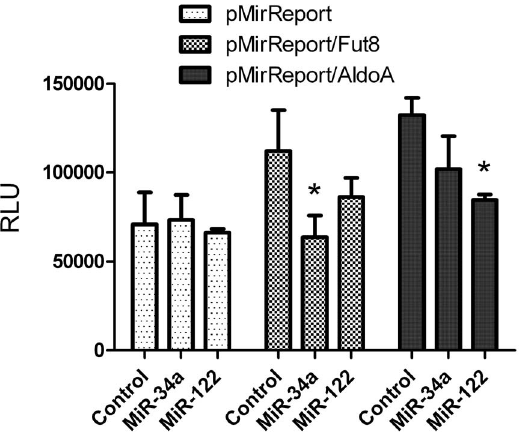
Figure 1. Effects of miR-122 and miR-34a on FUT8 and ALDOA 3 9 UTRs in a luciferase reporter assay. For each experiment, HeLa cells were seeded in 96 plates (six replicates for each condition) and they were then co-transfected with either miR-122 or miR-34a mimics and with empty pMiR-Report, with pMiR-Report containing down- stream FUT8 3 9 UTR (pMiR-Report/FUT8) or ALDOA 3 9 UTR (pMiR-Report/ ALDOA). Luciferase activity was determined after 24 hours post- transfection. Control=AllStar siRNA negative control. Data were expressed as luminescence units (RLU) means 6 SD of six replicates in three independent experiments. *p ,